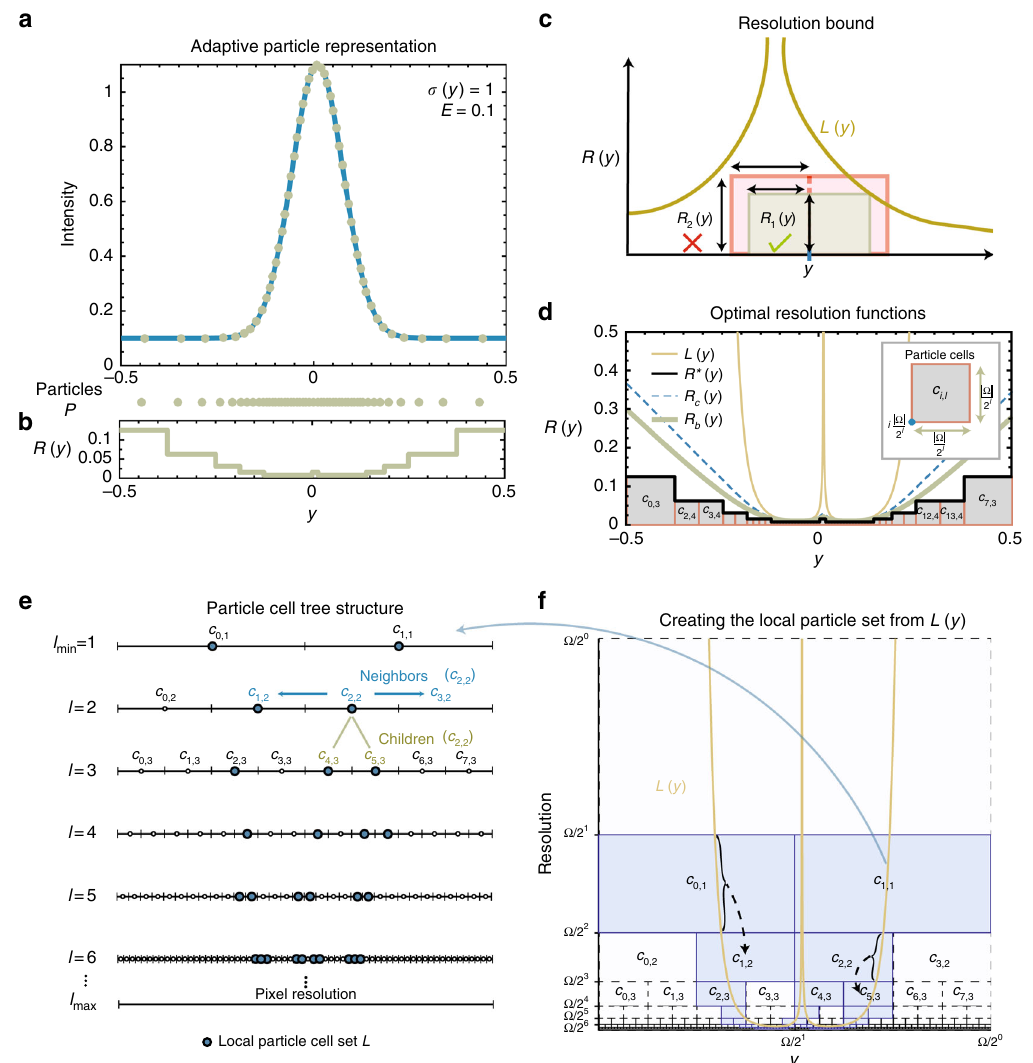
h i þ 0 : 1. 0 : 009